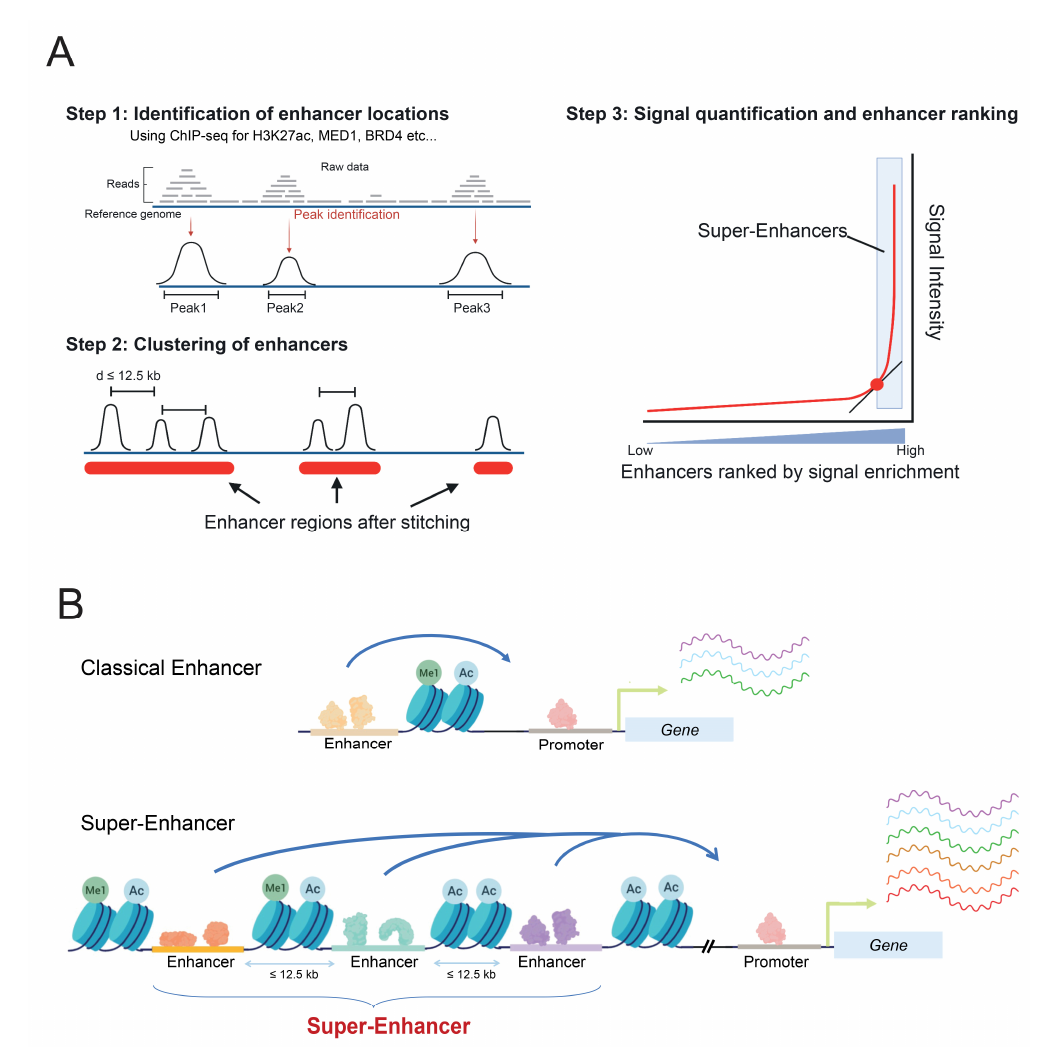
Figure 1. Definition of super ‐ enhancers. ( A ) Steps of identification and ranking of super ‐ enhancers: reads from ChIP ‐ seq for enhancer specific factors (such as MED1, BRD4) or histone modifications (H3K27ac, H3K4me1) are mapped to the reference genome and specific enrichment peaks are determined bioinformatically, then peaks closer than 12.5 kb are stitched together and the overall read signal intensity within these stitched areas is counted. Stitched regions are finally ranked by signal intensity, and super ‐ enhancers are defined as regions whose intensity is above the tangent of slop 1. ( B ) Super ‐ enhancers, as clusters of enhancers, are larger, present a higher TF and RNA pol II binding density, and induce a higher gene transcription compared to regular enhancers.